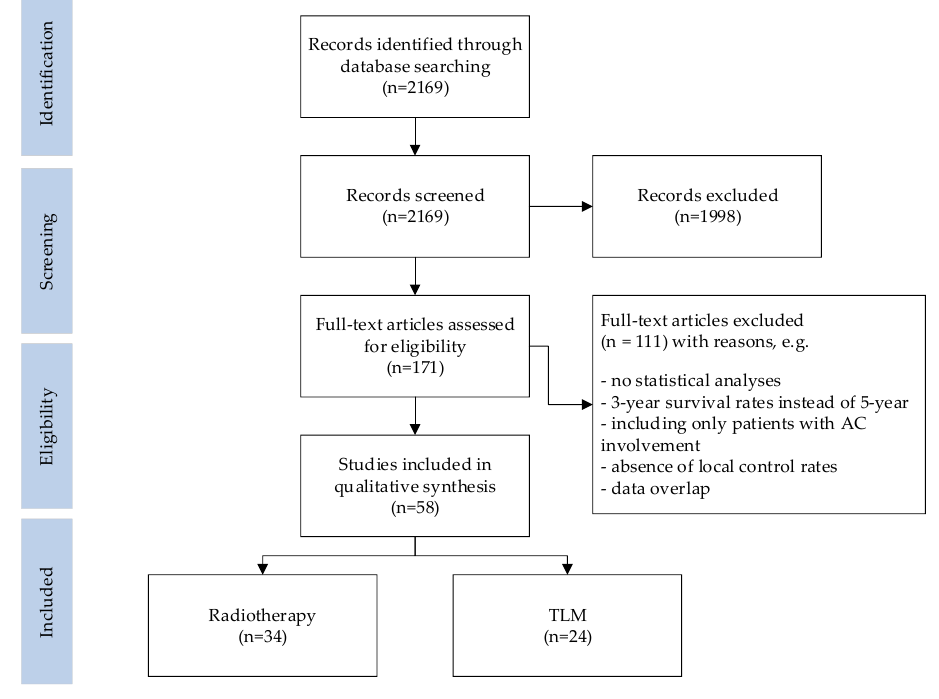
Figure 2. Flow diagram illustrating the searching and selection procedure.